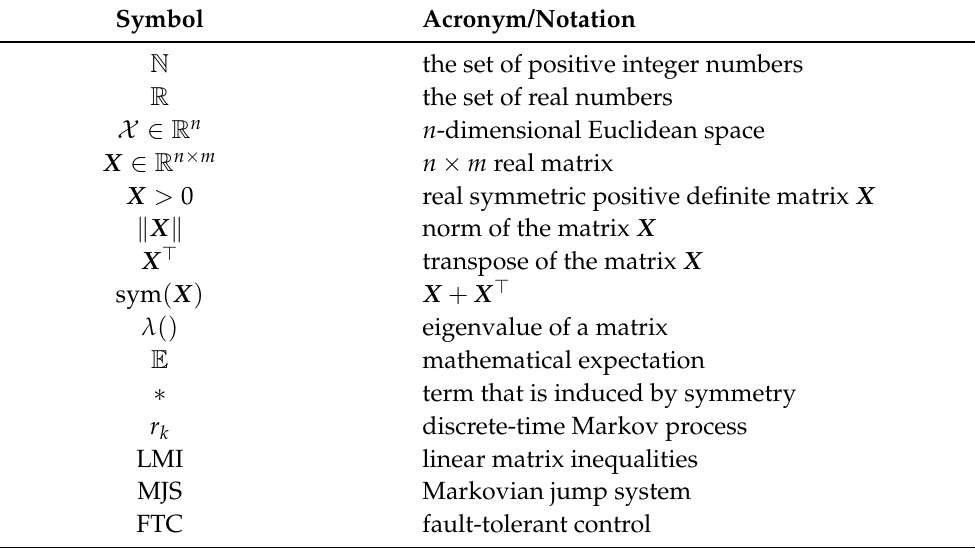
Table 1. Notations and acronyms used in the present